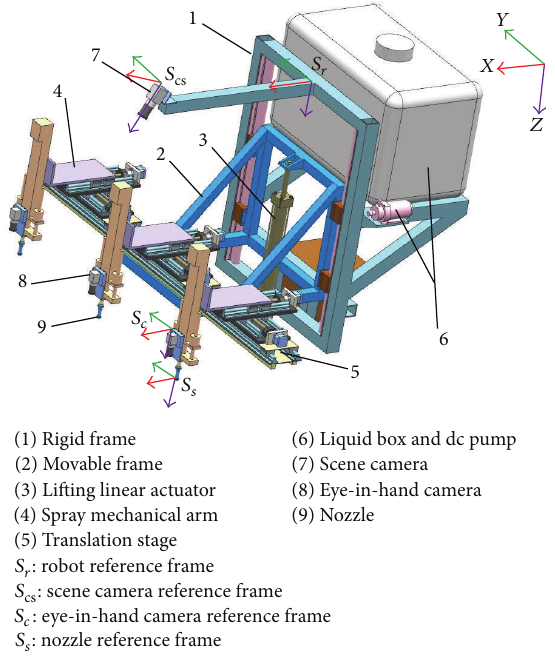
Figure 1: Robot body.